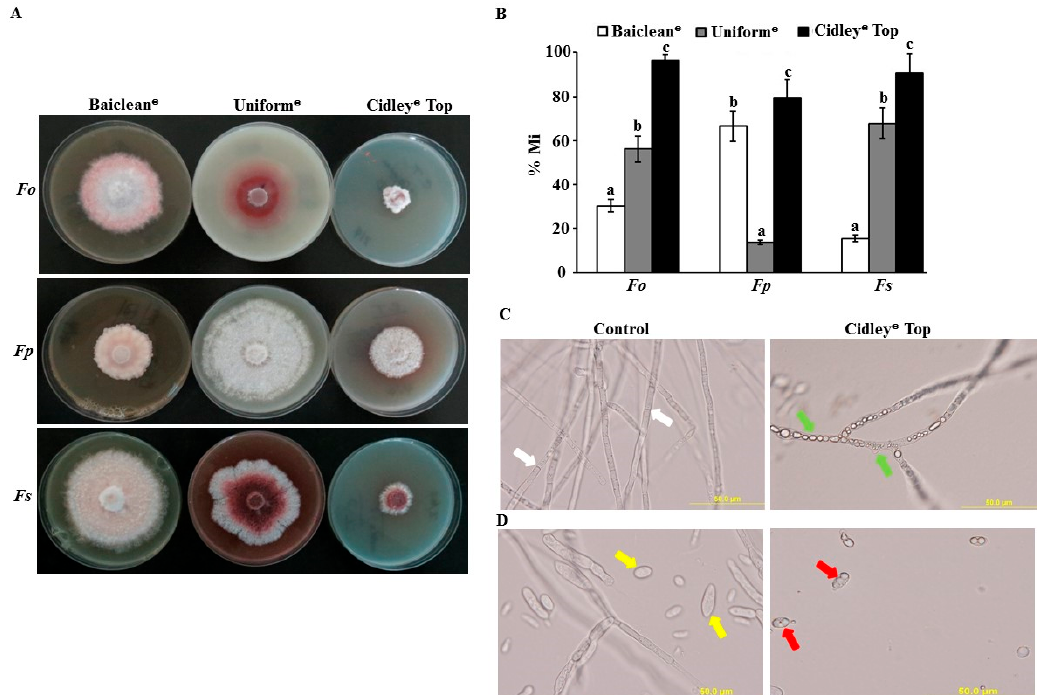
Figure 5. Efficacy of fungicides against Fusarium spp. in vitro. Effect of fungicides (250 ppm) on in vitro mycelial growth ( A ); growth inhibition rate (% Mi) of Fusarium spp. using 250 ppm of the fungicides after 10 days ( B ). Abnormalities in hyphal morphology, septum formation and cytoplasmic contents ( C ); and deformation of conidia ( D ) of F. solani following Cidely ® Top treatment compared to control. In (B) , values with different letters are significantly different from each other at p = 0.05; In (C) , white arrows indicate normal septate hyphal growth; and green arrows indicate formation of non-septate hyphal formation and cytoplasmic coagulation. In (D) , yellow arrows indicate normal formation of conidia; and red arrows indicate deformation of conidia. Fo , F. oxysporum ; Fp , F. proliferatum ; Fs , F. solani .